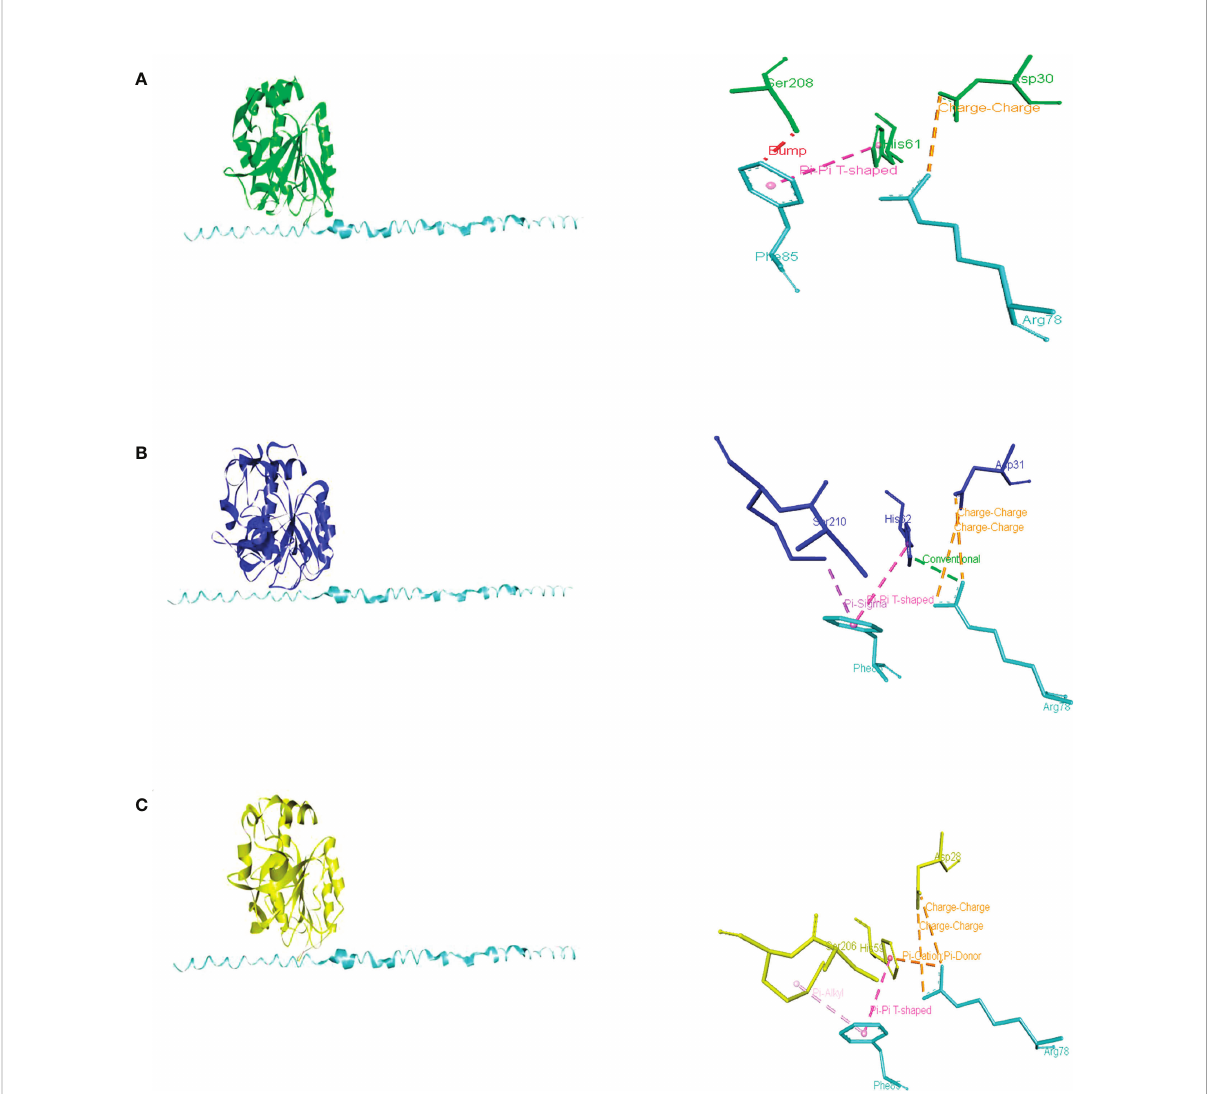
FIGURE 6 Intermolecular interactions of inhibitory peptide Um10059 (Um2129) (cyan) with PrBSc (A) , PrBUm (B) , and PrBAa (C) . Dotted lines indicate the type of interactions. For the purpose of clarity, the interactions between the amino acid residues of the PrB catalytic triad (Asp, His, and Ser) and the inhibitory Um10059 are shown. The interactions with M. oryzae were not shown since none of the residues of the catalytic triad interact with the inhibitor of U. maydis